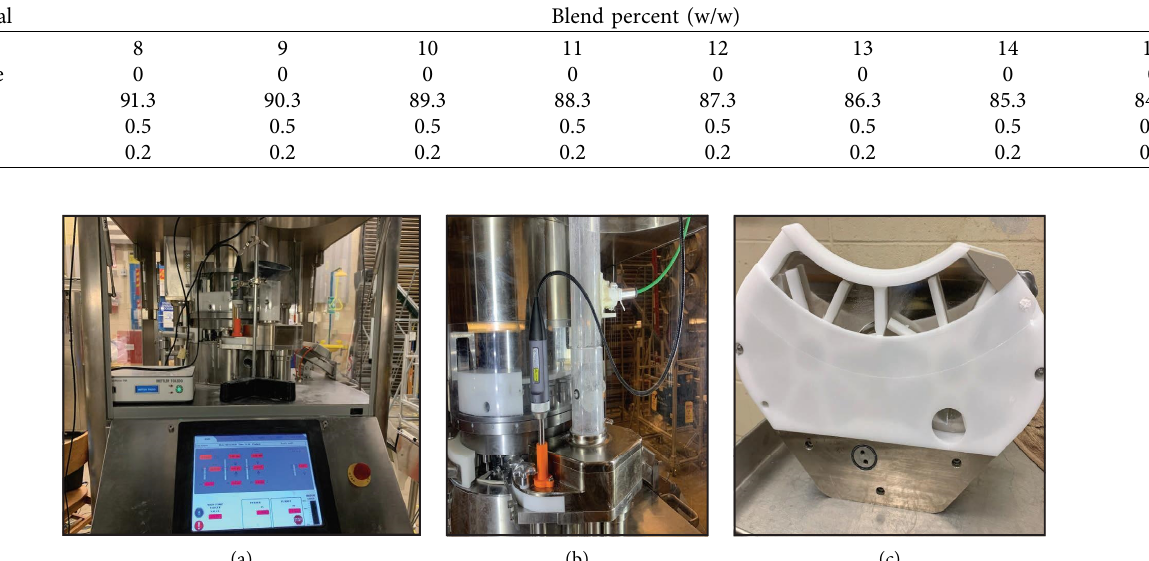
Figure 1: (a) Tablet press and Raman spectrometer, (b) 3D printed sensor holder, and (c) feed-frame of Natoli NP 400 tablet press.